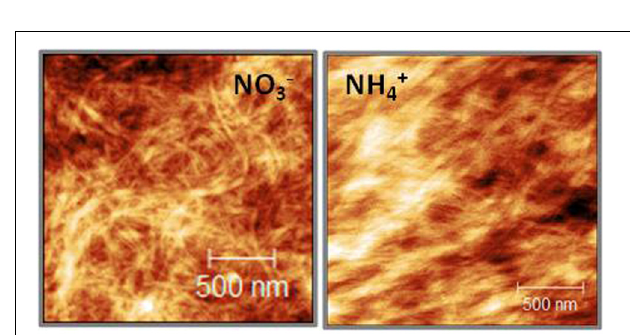
FIGURE 3 | Atomic force micrograph (height mode image) of partially hydrated, isolated cell walls of A. thaliana leaves of plants growing on NH 4 + and NO 3 − (control) as the only N source. All images are 2 µ m × 2 µ